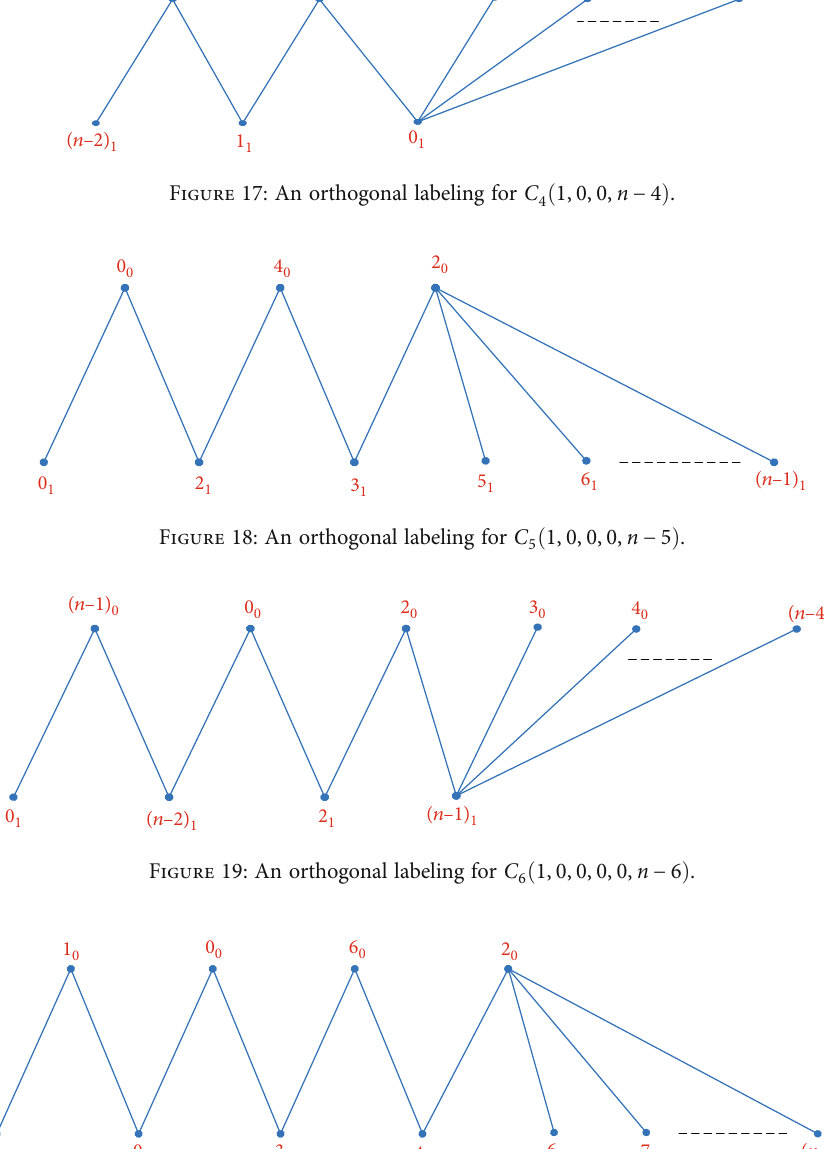
ð 1, 0, 0, 0, 0, 0, n − 7 Þ 7